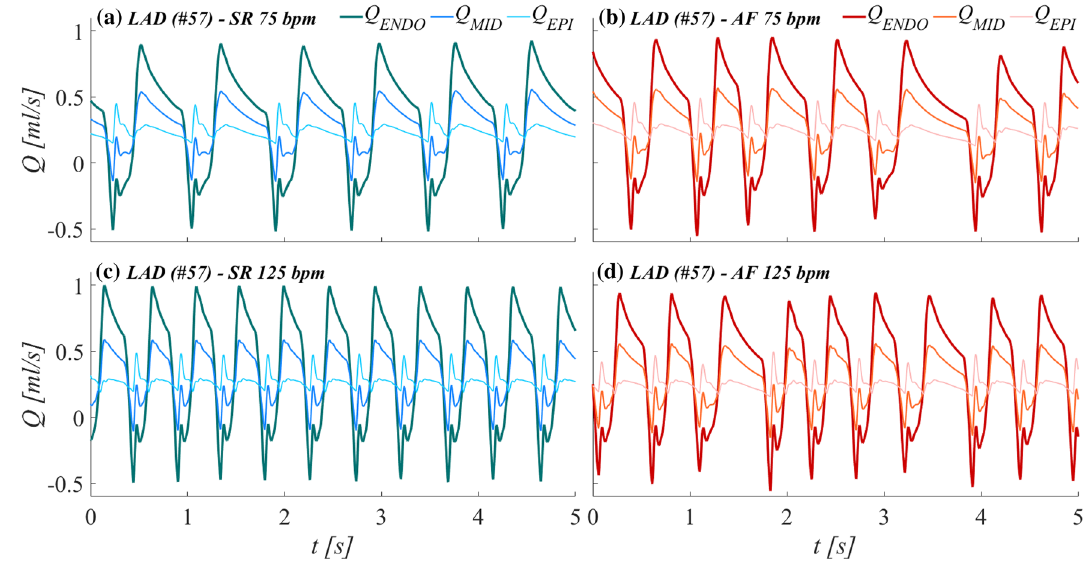
Figure 3. Examples of flow rate time-series Q(t) for the three myocardial layers (EPI: subepicardium; MID: midwall; ENDO: subendocardium) of the LAD coronary microvascular district (vessel #57). (a) SR at 75 bpm; (b) AF at 75 bpm; (c) SR at 125 bpm; (d) AF at 125